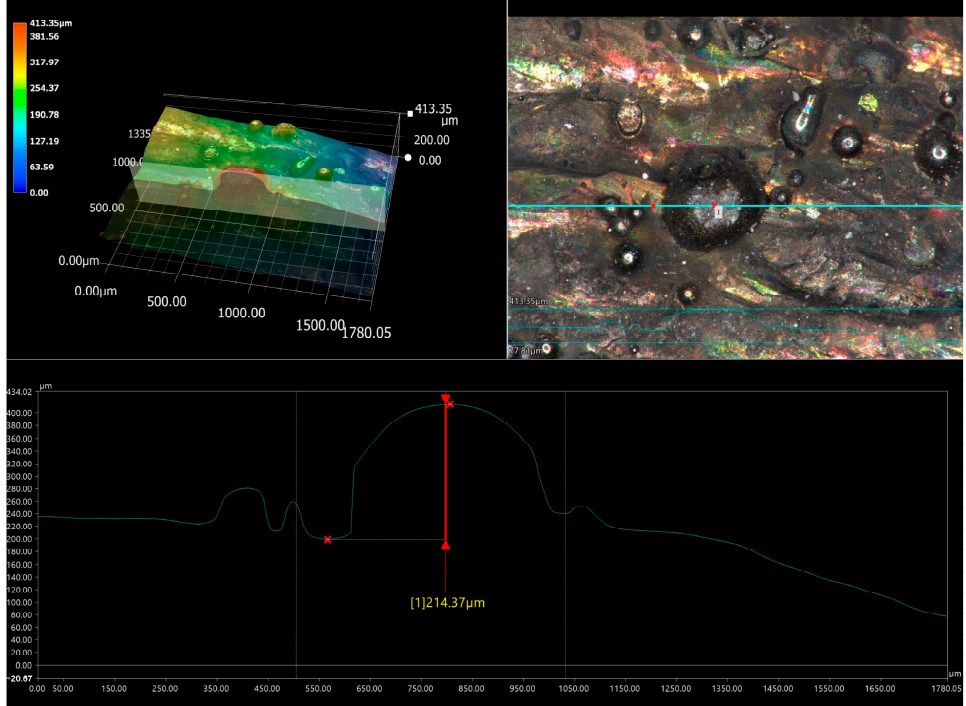
Figure 14. The cross-section of the 3D image of the surface topography and the 2D profile across the WC particle for the specimen laser-alloyed with a laser beam power of 1.3 kW; 1—measuring point of the relative height of the WC